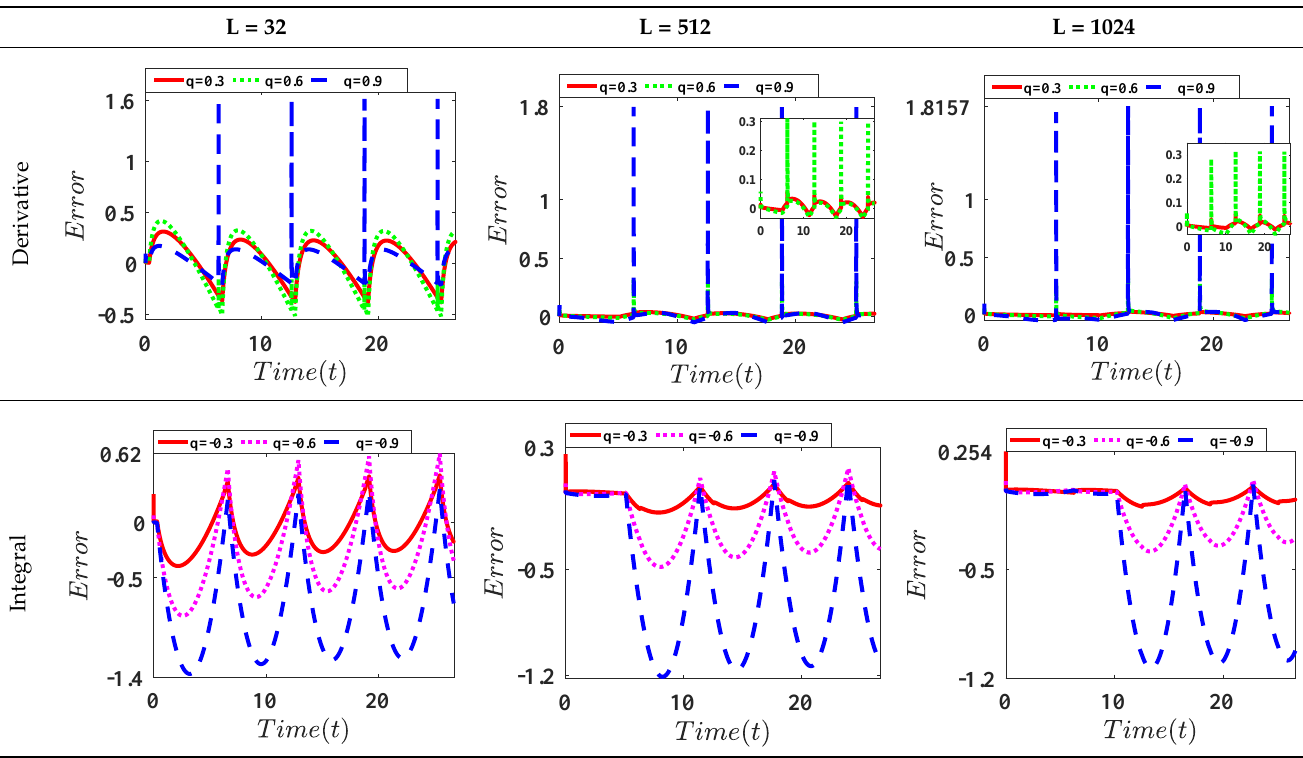
Table 3. The error of the proposed design results (differentiator and integrator) for a sawtooth signal input with respect to MATLAB results.